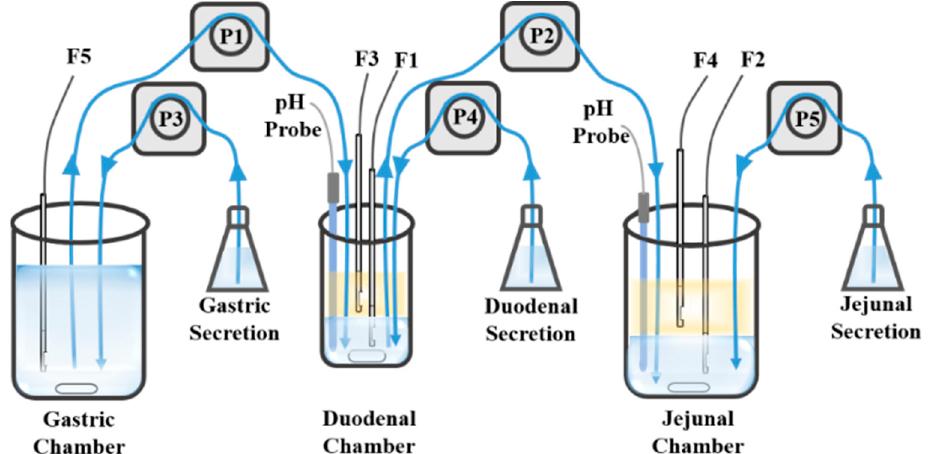
Figure 6. The schematic of BGIS. The blue blocks represent the aqueous phase, the yellow blocks represent the organic phase, F1–F5 represent the fiber optical probes, P1–P5 represent the pumps, the blue lines represent the tubes and the arrows represent the direction of the fluid. Adapted with permission from Ref. [115]. 2023, Elsevier.